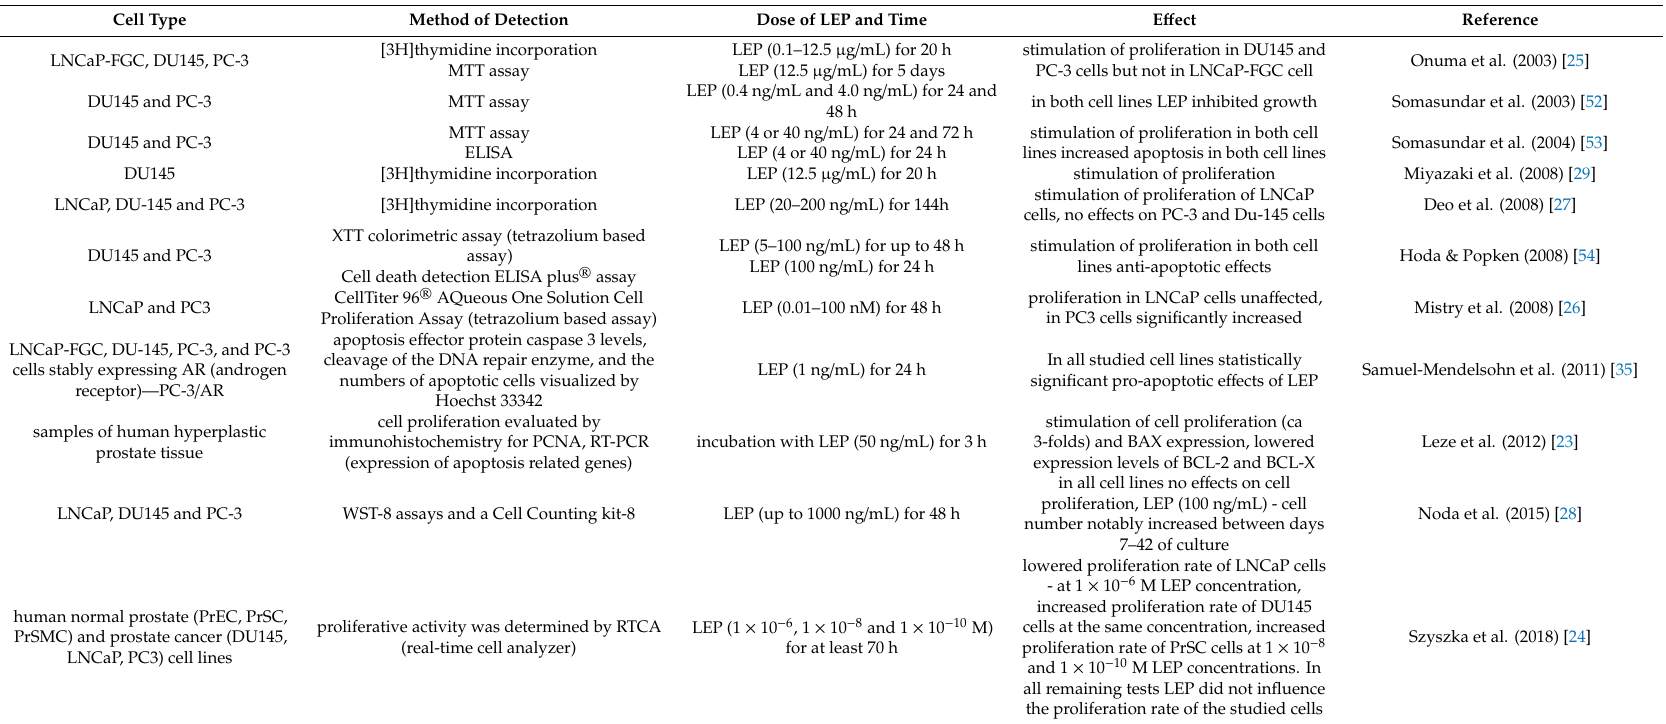
Table 1. Literature data on the e ff ect of leptin (LEP) on proliferation and apoptosis in human normal prostate and prostate cancer cell